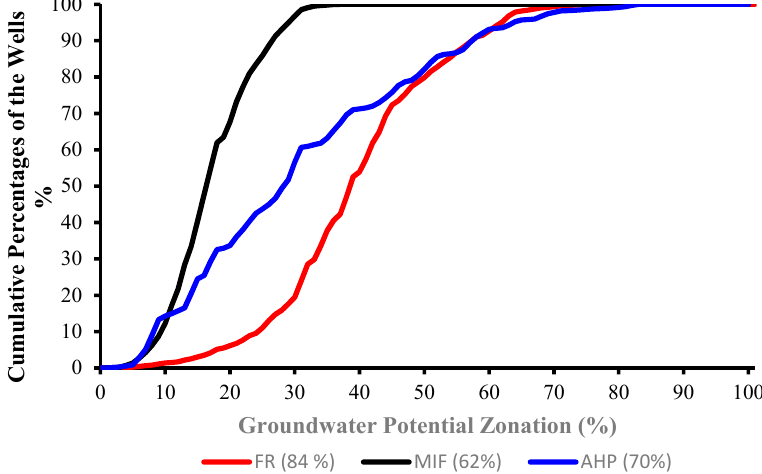
Figure 12. Receiver operating curves for validation of groundwater potential maps.